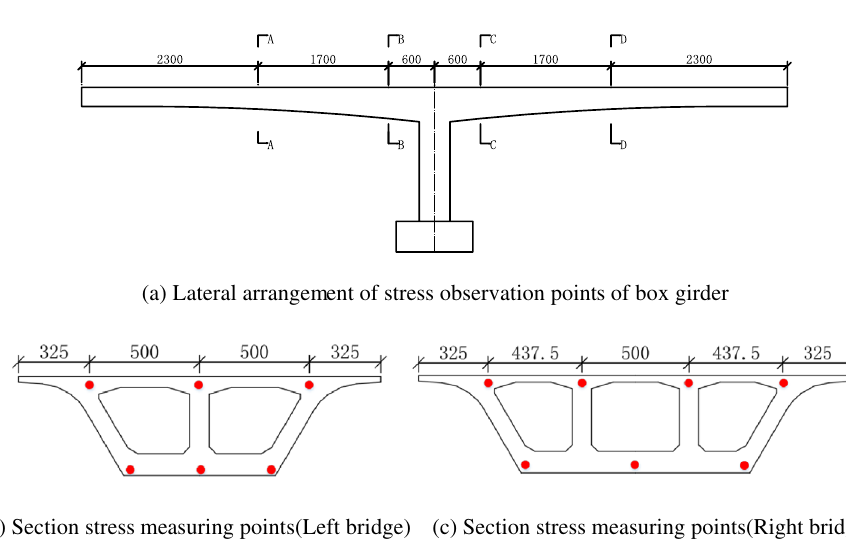
(b) Section stress measuring points(Left bridge) (c) Section stress measuring points(Right bridge) Figure 7. Arrangement of stress measured of girder (cm).